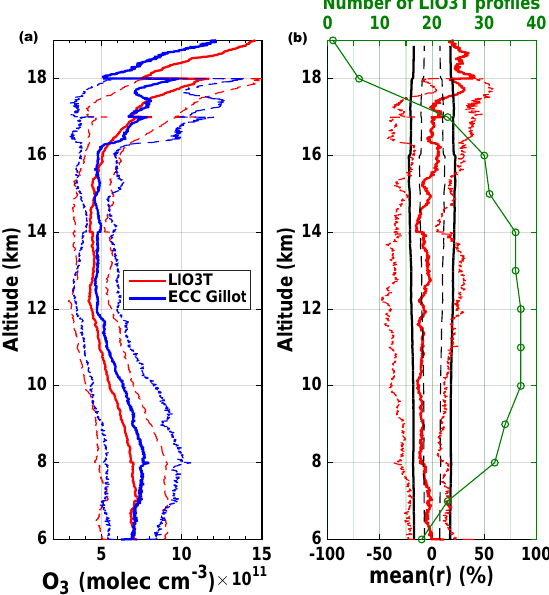
Figure 5. (a) Mean LIO3T O 3 profile (red curve) and mean ECC profile (blue curve) measured during the eight intercomparison measurements performed at Maïdo. The dashed lines give the 1 standard deviation around the mean. (b) Mean r between the LIO3T and ECC profiles (red curve), mean LIO3T uncertainty around zero (black dashed lines) and mean LIO3T uncertainty and ECC pre- cision around zero (black lines). The red dashed lines give the 1 standard deviation around the r mean. The green line (upper x axis) gives the number of LIO3T profiles used for comparison.